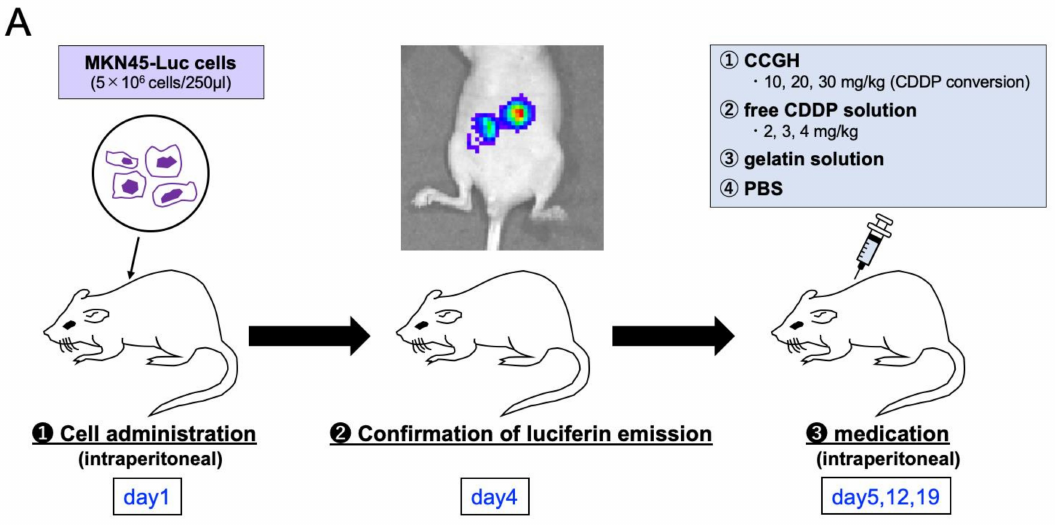
Figure 6. In vivo toxicity evaluation after treatment (day 1) in mice. ( A ) The profiles of body weight change. CCGH (10 mg/kg; double dot-dash line), CCGH (30 mg/kg; double line), free CDDP solution (2 mg/kg; dotted line), free CDDP solution (4 mg/kg; dot-dash line), and gelatin solution (thin solid line). ( n = 5). Data were represented as mean ± SD. ( B – F ) Hematological examination data on day 10. ( B ) Serum concentrations of blood urea nitrogen (BUN). ( C ) Serum concentrations of creatinine (Cre). ( D ) Numbers of white blood cells (WBCs). ( E ) Numbers of red blood cells (RBCs). ( F ) Numbers of platelets. CCGH (10 mg/kg), CCGH (30 mg/kg), free CDDP solution (2 mg/kg), free CDDP solution (4 mg/kg), and gelatin solution. ( n = 5).